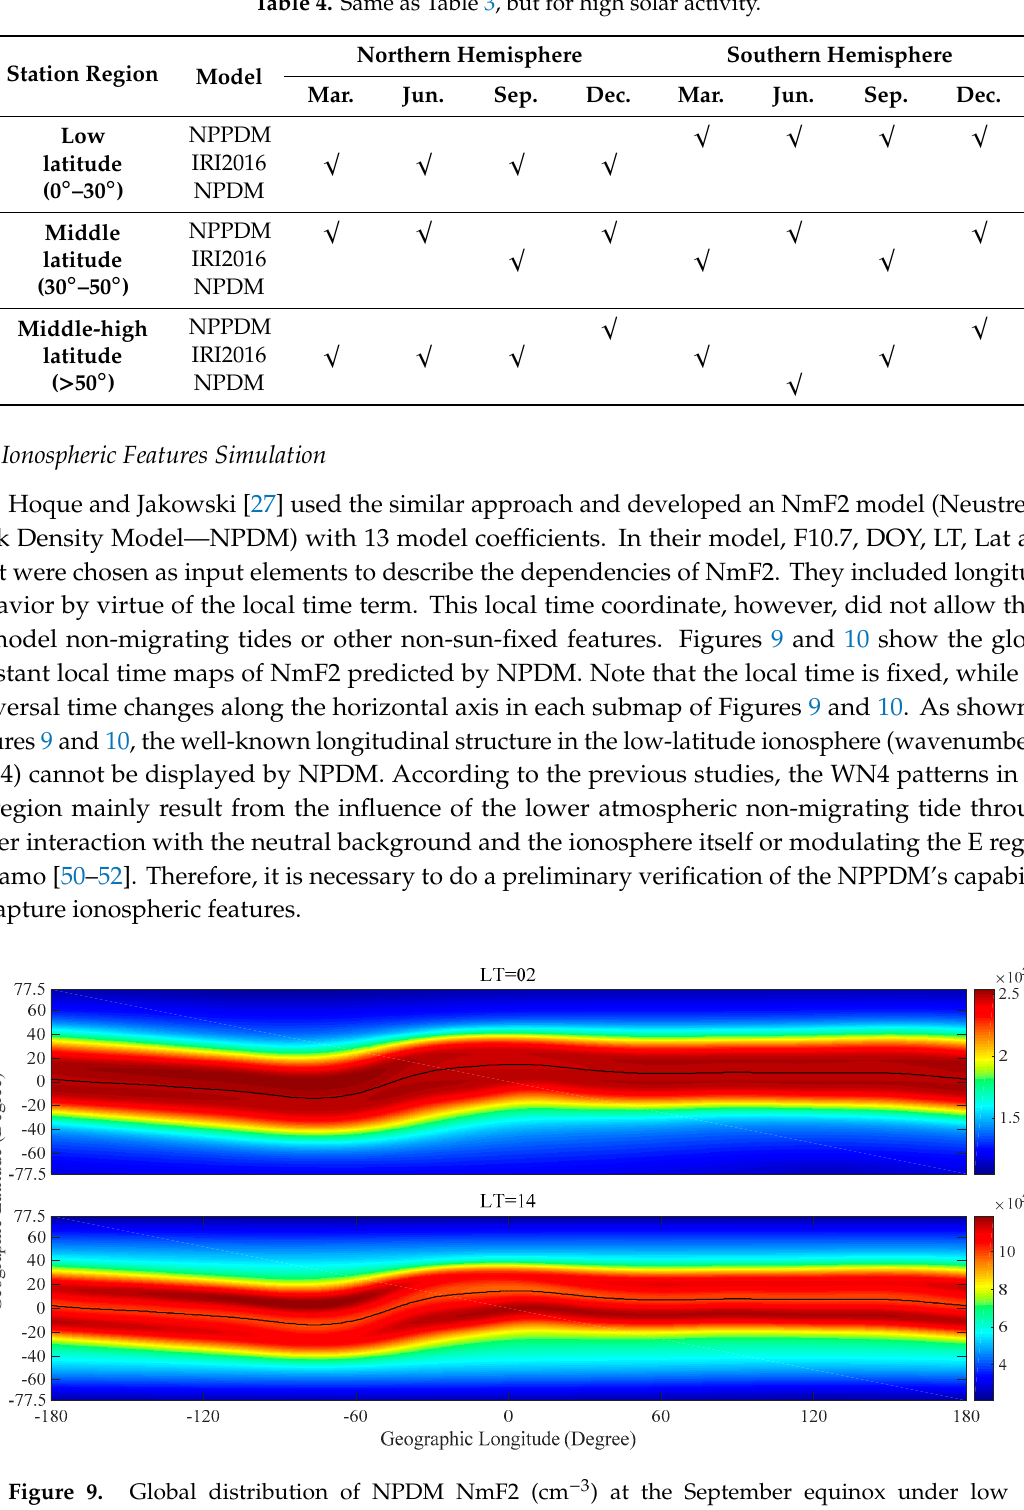
Figure 10. Same as Fig.9, but for high (F10.7=150 sfu) solar activity. To validate the capability of NPPDM to present the expected latitudinal features, the global distributions of NmF2 at 08 UT and 20 UT under moderate solar activity (F10.7=120 sfu) produced by NPPDM at the September equinox are shown in Figure 11. In the day sector of Figure 11, when the ionosphere is irradiated, a pronounced double peak centers around ±20–±40° dip on either side of the magnetic dip equator (black curves), which is known as the EIA. This phenomenon is induced by the well-known fountain effect, which lifts the equatorial plasma through E B ×   to a height of several hundreds of kilometers [53-54]. The plasma diffuses downward along magnetic field lines under the influence of gravity and pressure gradient forces after the plasma is lifted to greater heights. In Figure 11, the EIA asymmetry is also shown: the denser Nmf2 is in either the northern or the southern hemisphere, where neutral winds are equatorward [55].